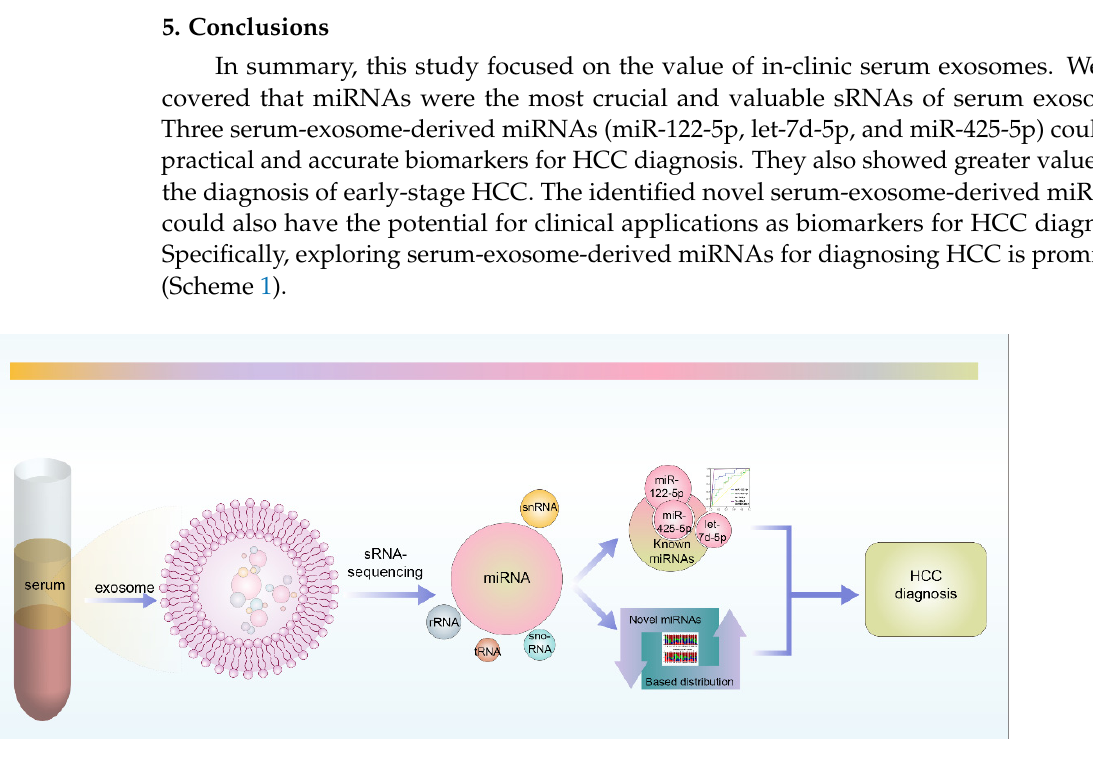
Figure S2: The error rate of each base less than 0.05% representing the high quality of sRNAs sequencing. Figure S3: Base bias of serum-exosome-derived miRNAs from four HCC patients and four non-tumor donors. Figure S4: The heatmap depicts the expression of serum-exosome-derived miRNAs from HCC patients and non-tumor donors. Figure S5: The area under the receptor-operated curve (AUROC) values of the three serum-exosome-derived miRNAs and AFP with a cutoff of 100 ng/mL or 400 ng/mL in the diagnosis of HCC. Figure S6: The area under the receptor-operated curve (AUROC) values of the three serum-exosome-derived miRNAs in the diagnosis of HCC with high and low AFP. Figure S7: The area under the receptor-operated curve (AUROC) values of the three serum-exosome-derived miRNAs in the diagnosis of HCC with a low and high stage (training set). Figure S8: The volcano plot depicts differentially expressed novel miRNAs between four HCC patients and four non-tumor donors. Figure S9: The structure of the three differentially expressed novel miRNAs. Figure S10: Base bias of novel miRNAs from serum exosomes in four HCC patients and four non-tumor donors. Figure S11: The Original whole Western blot. Table S1: The characteristics of 124 HCC patients. Table S2: The characteristics of four randomly selected patients for sRNA-sequencing. Table S3: The sequences of primers for miRNA amplification. Table S4: